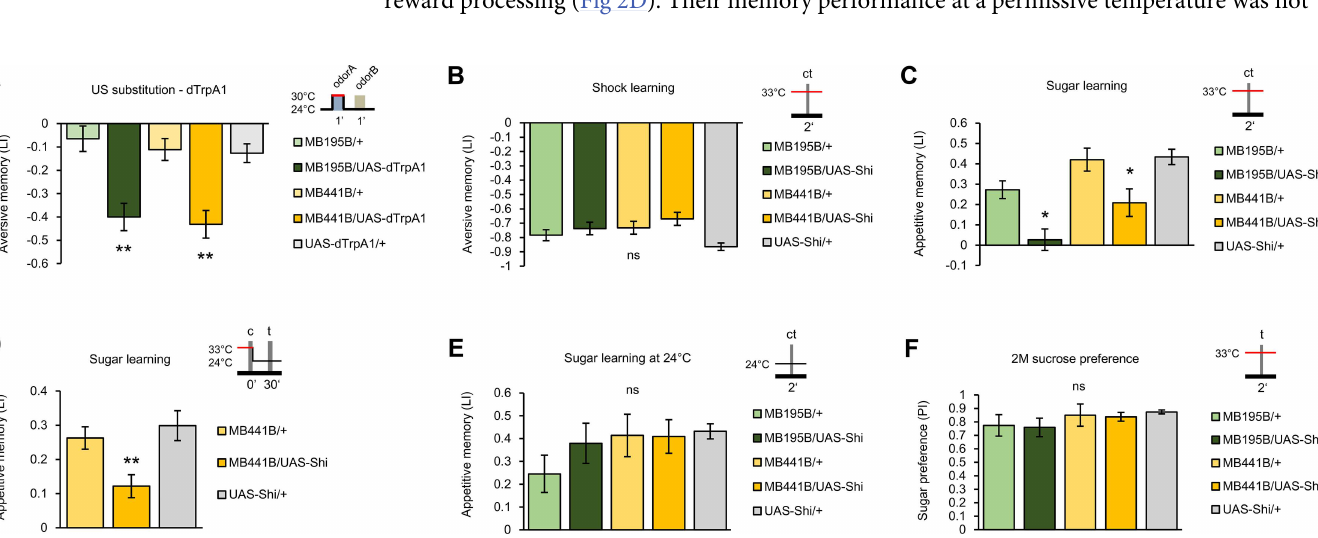
Fig 2. PAM- γ 3neurons are involved in acquisition of both aversiveand appetitive memories. (A) Thermoactivation with MB441B-GAL4 and MB195B-GAL4 pairedwith an odor inducesaversive memory of the pairedodor. LI, learningindex; n = 7–10. (B) Blockadeof the PAM- γ 3 neurons in MB441B-GAL4 / UAS-shi ts1 and MB195B-GAL4 / UAS-shi ts1 flies leaves electric shock–reinforced immediateaversive memory intact. n = 8. (C) In contrast, the same blockadeimpairs sugar-rewardedimmediateappetitivememory. n = 12–20. These data are reproducedwith the same genotypes, but outcrossed with a wild-type strain for four generations(S2 Fig). (D) Transient blockadeof PAM- γ 3during trainingimpairs acquisitionof appetitivememory. n = 23–35. (E) The performance of MB441B-GAL4/UAS-shi ts1 and MB195B-GAL4/UAS-shi ts1 flies is normal at a permissive temperature (24˚C, 30 min memory). n = 8. (F) Blockadeof PAM- γ 3 with MB441B-GAL4/UAS-shi ts1 or MB195B-GAL4/UAS-shi ts1 does not impairinnate sucrose preference.PI, performanceindex; n = 6–8. c, conditioning; t, test. Bars and error bars indicate means and standarderror of the mean (SEM), respectively,throughoutthis study. The numerical data used in all figures are includedin S1 Data. * p < 0.05, ** p < 0.01; ns, not